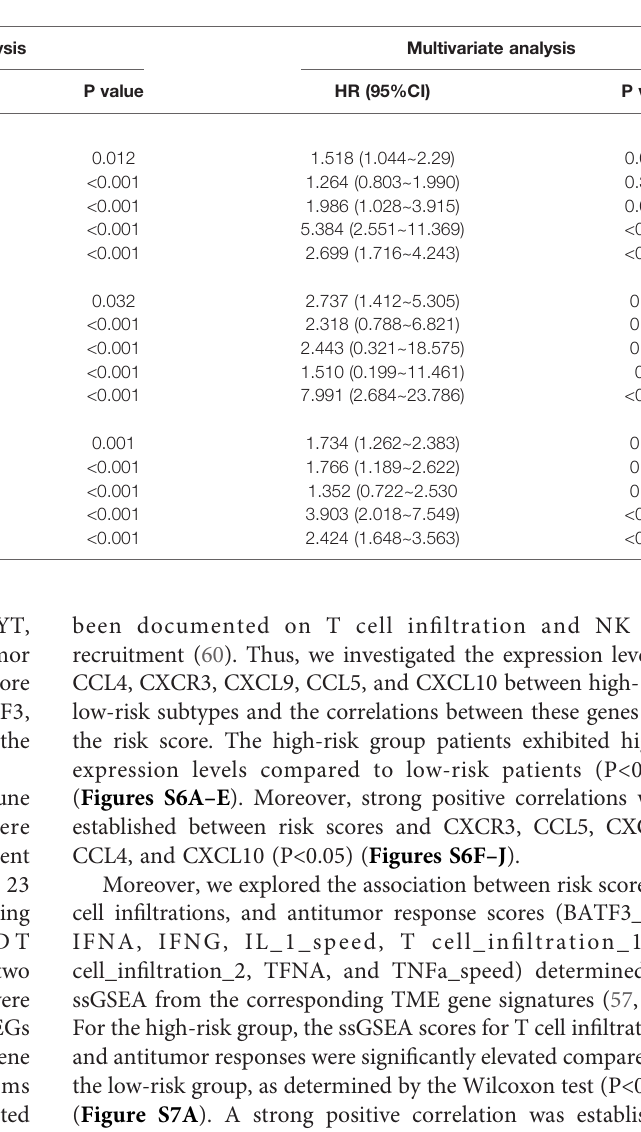
TABLE 2 | Univariate and multivariate Cox regression